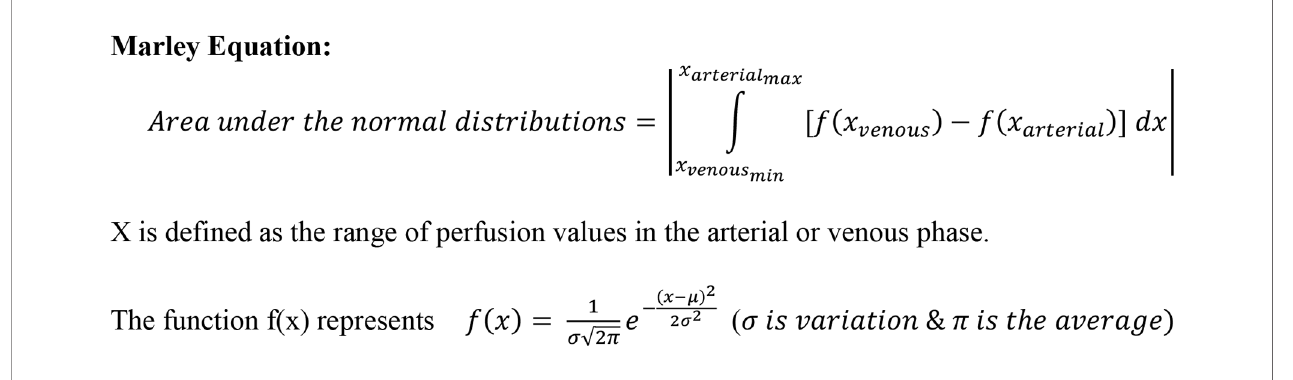
FIGURE 3 | The Marley Equation.